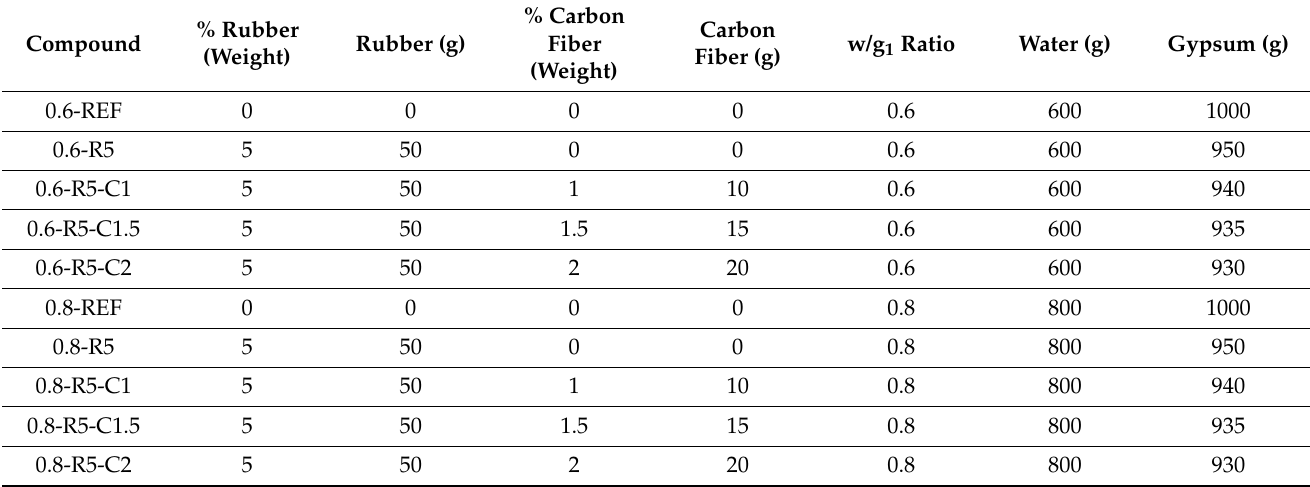
Table 5. Name and composition of the mixes studied.